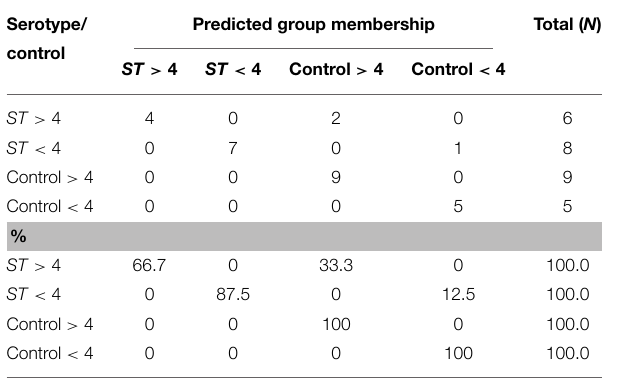
and (vii) Candida spp.; as well as (viii) the degree of dysbiosis, (ix) age ofsubjects, and (x) IgE concentration. IgE concentration is omitted in models in column A and included in column B